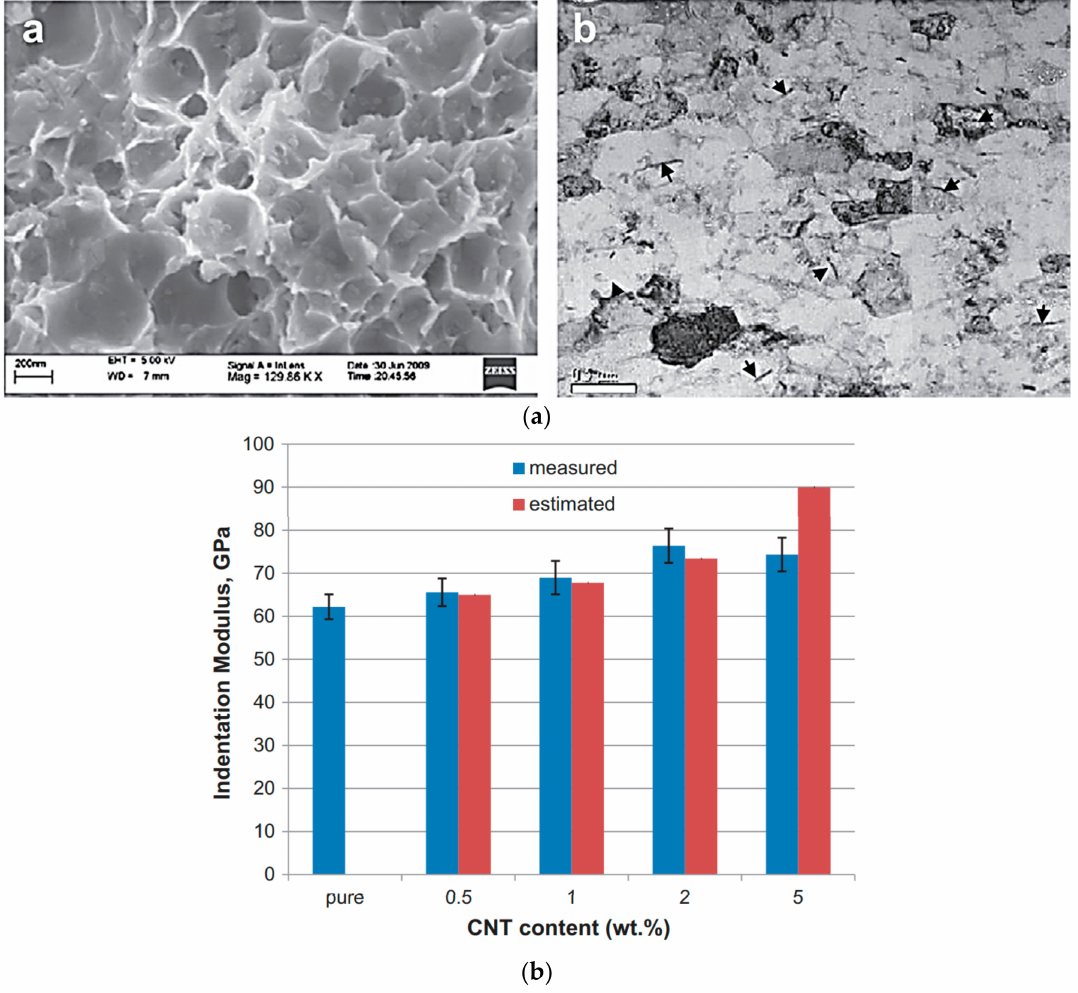
Figure 7. CNTs are suitable for strength reinforcement. ( a ) SEM image of surface of an Al–2 wt.% CNT and TEM image of an Al–2 wt.% CNT showing dispersed CNTs (indicated by arrows) within the Al matrix. ( b ) Effect of CNT content and estimated modulus values in the indentation modulus of investigated composites (reproduced from [112] with permission, copyright Elsevier,